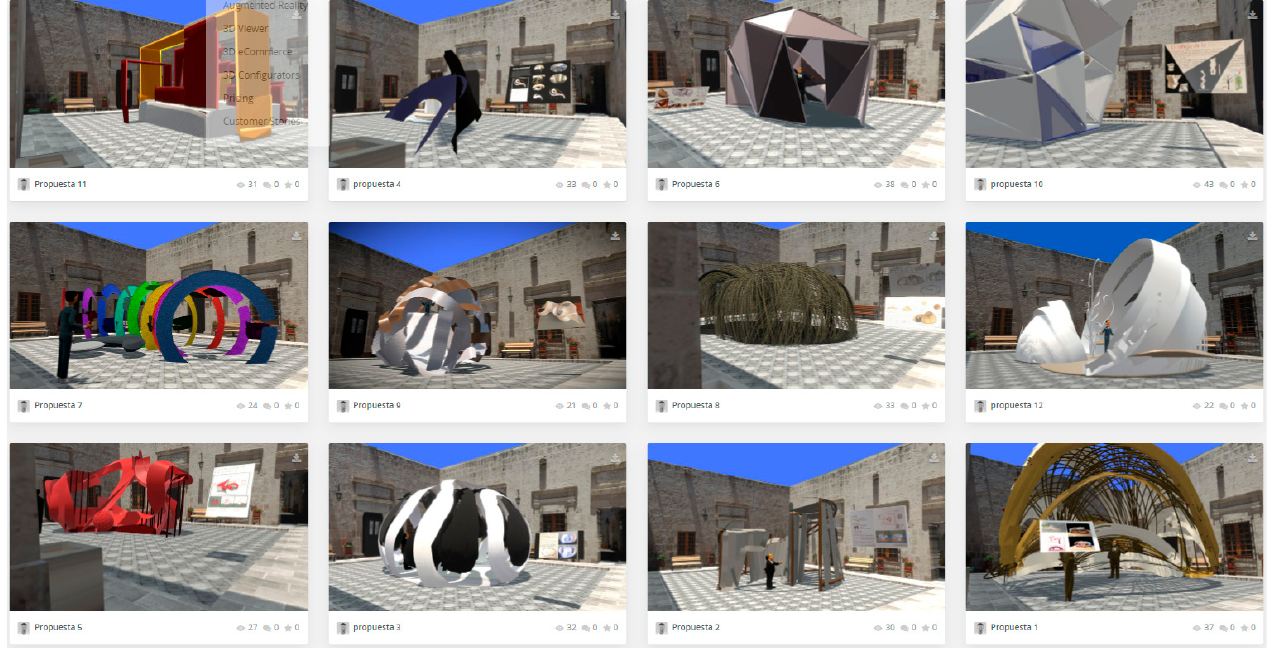
Figure 5. The third phase: a schematic design using IVR by the 12 students, on the Sketchfab plat- form. (https://sketchfab.com/johnbel/collections/rv4 (accessed on 18 February